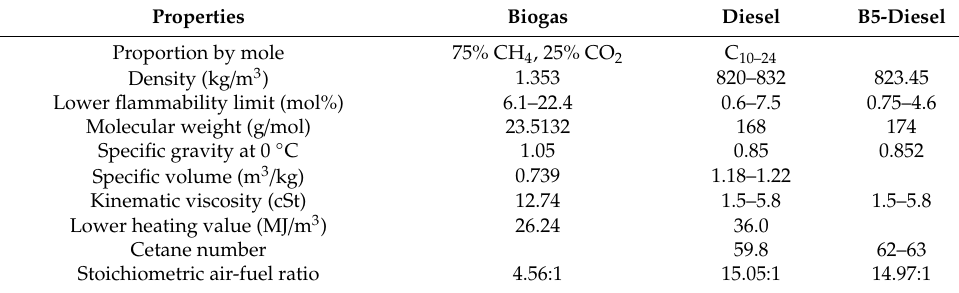
Table 3. Characteristics of the fuels used for the test.